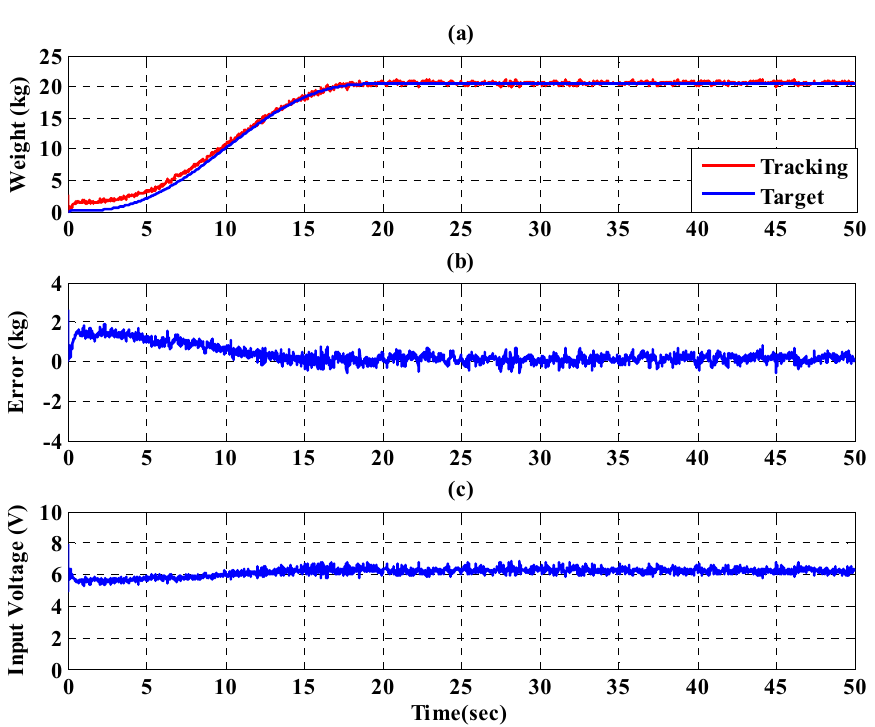
Figure 21. Experimental results for the PBWSS with a static bodyweight unloading force of 30% (20.4 kg) in 50 s. ( a ) Tracking trajectory; ( b ) tracking error; ( c ) control voltage.